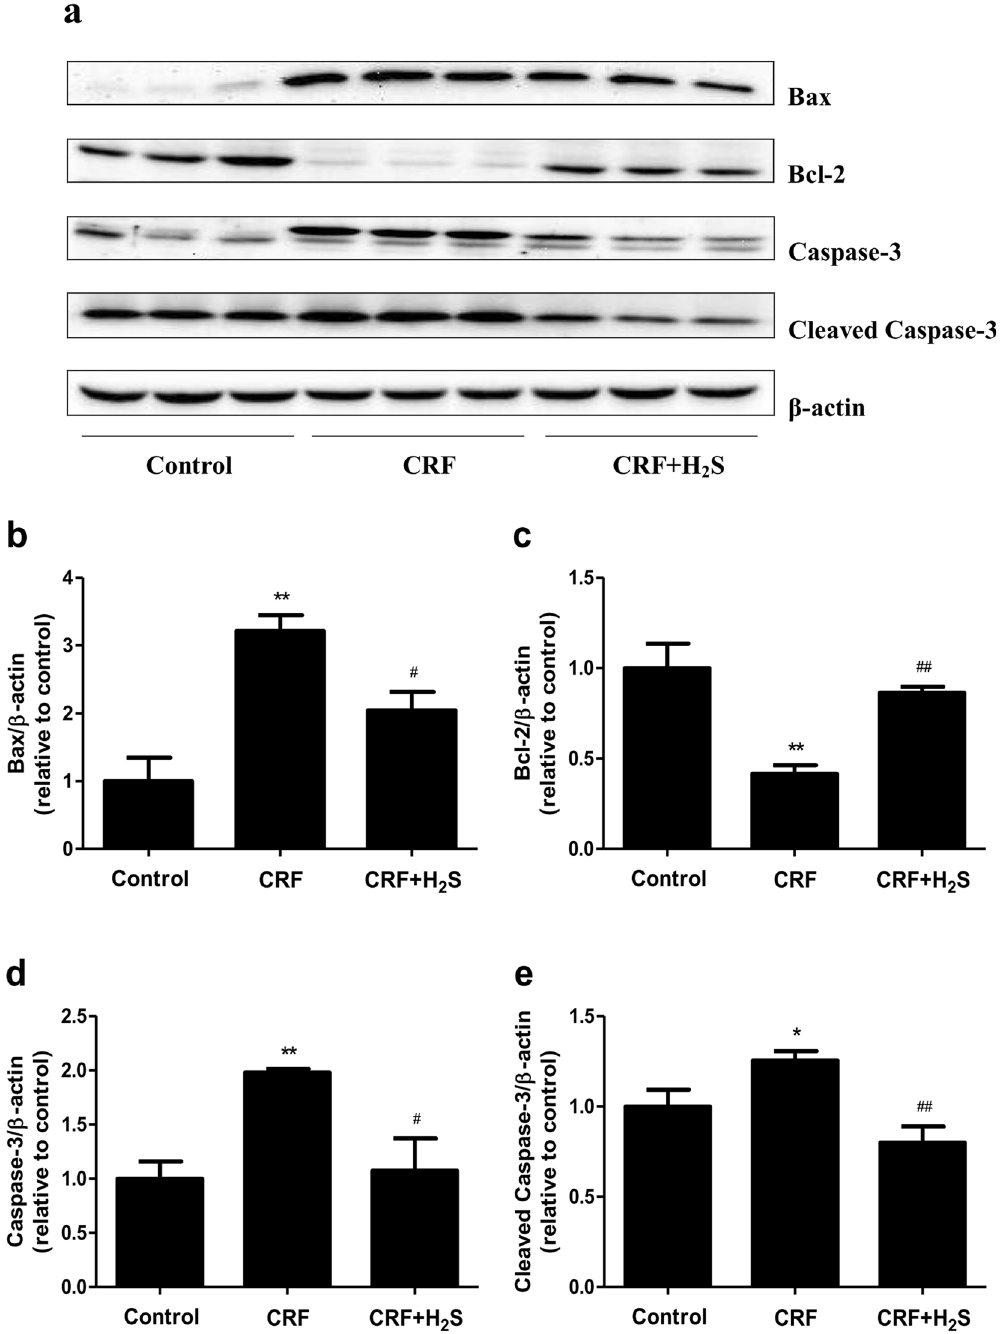
Figure 6. Effects of H 2 S on the protein expression of Bax, Bcl-2, Caspase-3, and Cleaved Caspase-3 in the kidney of CRF rats were measured. (a) The expression levels of Bax, Bcl-2, Caspase-3, and Cleaved Caspase-3 were detected by Western blot. β -actin was used as an internal control. Bar graphs showed the quantification of Bax (b), Bcl-2 (c), Caspase-3 (d), and Cleaved Caspase-3 (e). Values were presented as mean ± SEM (n = 3); * P < 0.05, ** P < 0.01 compared with the control group; # P < 0.05, ## P < 0.01 compared with the CRF